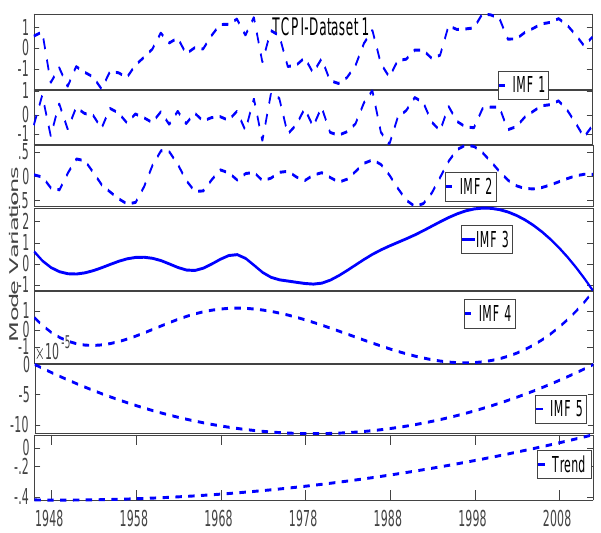
Figure 2. EMD analysis of the TCPI signal in the North Indian Ocean. TCPI derived using Dataset-1. The signal is shown in the first panel. The following panels illustrate its intrinsic modes. The trend of the signal shows a rise from 1958 onwards (Panel-7). Table 1. Correlation Coefficient (CC) values of the TCPI modes and the signal derived from Dataset-1. Signal-Mode Number CC Signal, IMF-1 0.4725